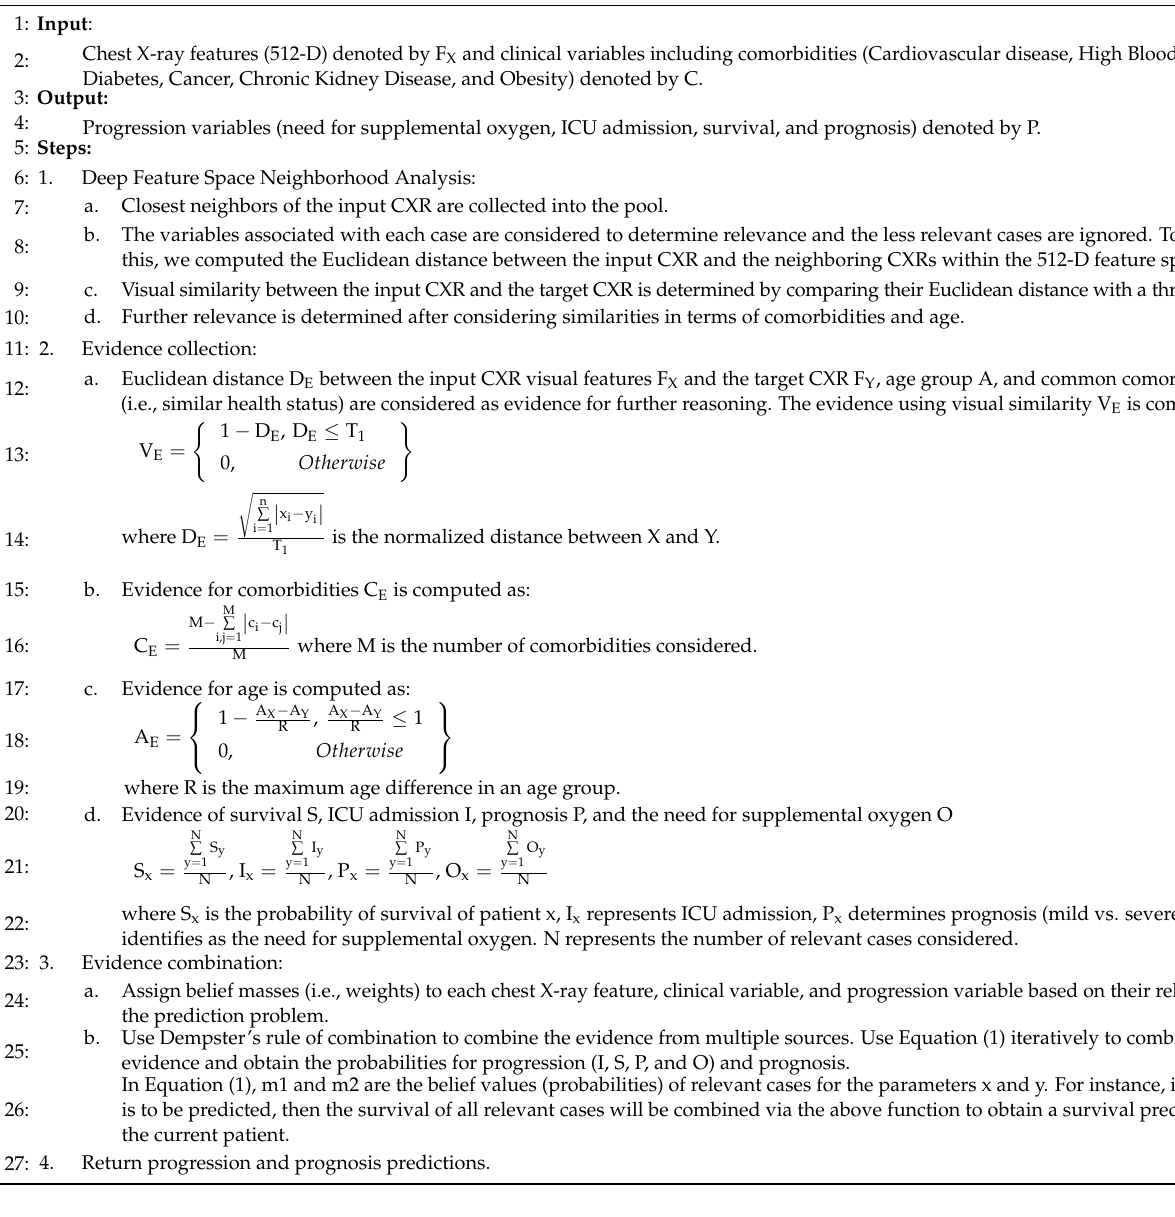
Algorithm 3: Deep Feature Space Reasoning for